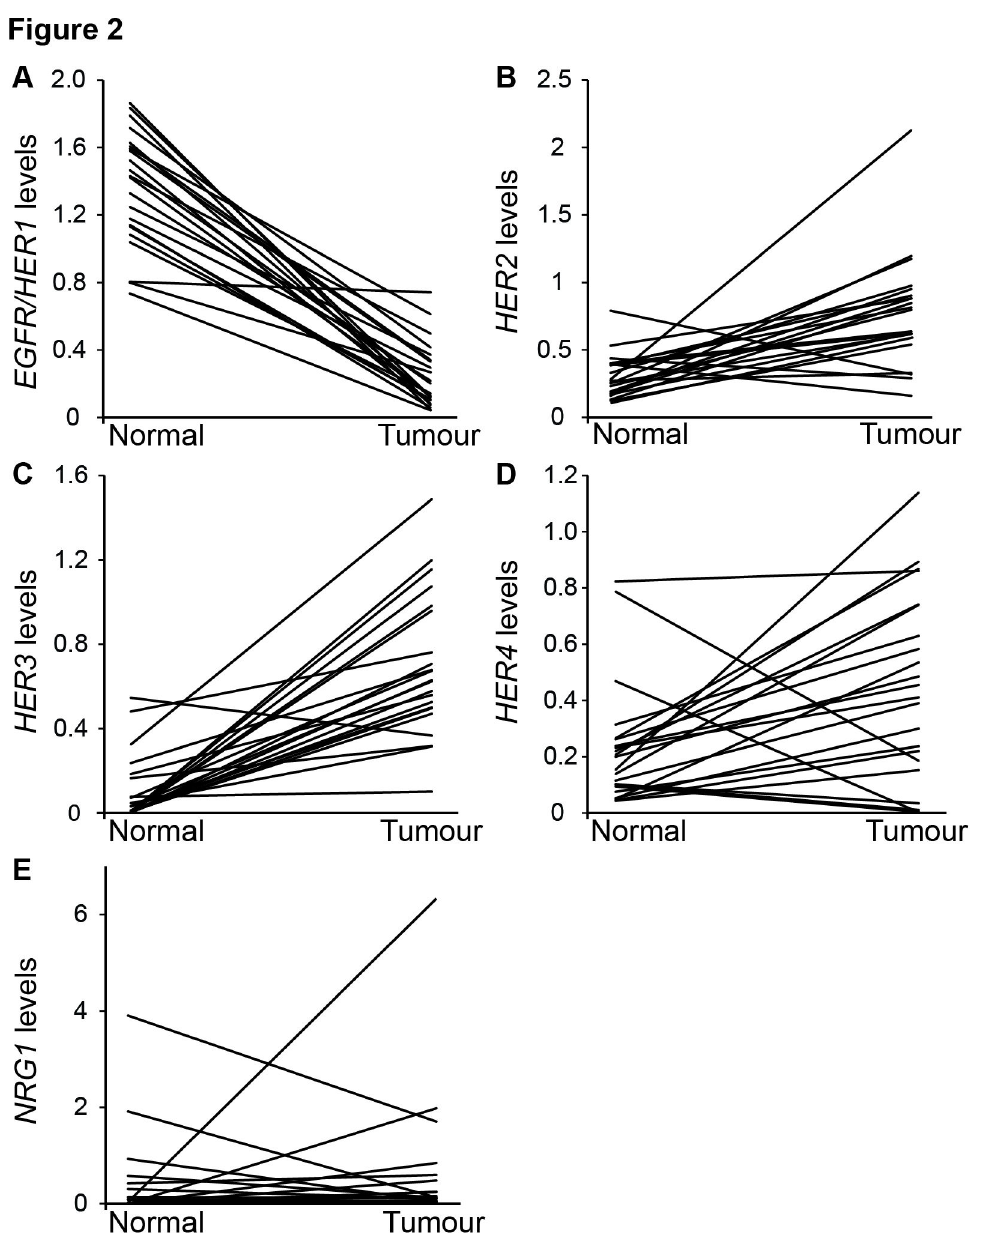
Figure 2. Changes in HER1-4 and NRG1 expression levels from normal to tumour breast tissue. Individual mRNA levels of EGFR/HER1 (A), HER2 (B), HER3 (C), HER4 (D) and NRG1 (E) from normal and tumour tissue from each postmenopausal patient.